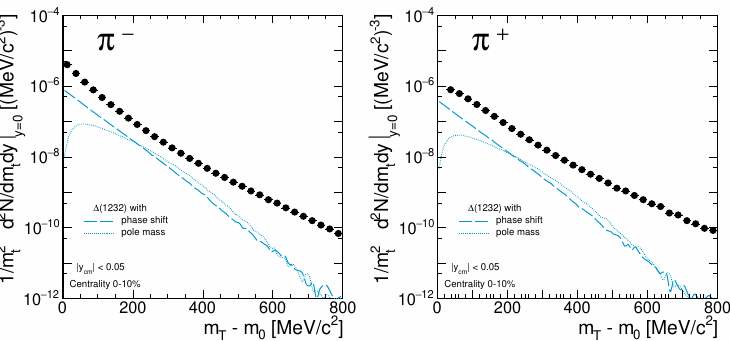
Figure 1. Transverse mass distributions of π − (left panel) and π + (right panel) at mid-rapidity, measured by HADES [4] overlaid with contribution from decays of ∆ (1232), calculated with mass distribution from [10] (blue solid curves) and with zero width at nominal mass (blue dashed